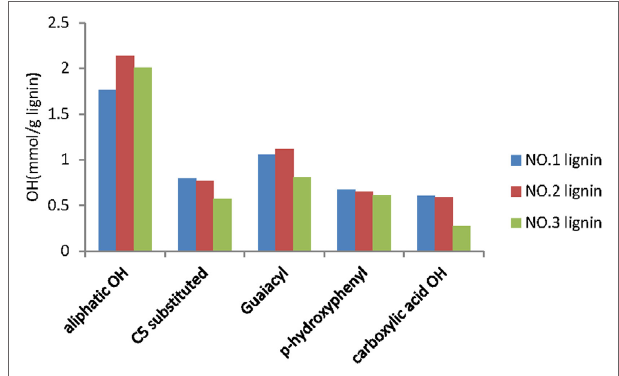
FigUre 4 | 31 P-NMR spectra analysis results of lignin fractions from dilute acid pretreated switchgrass.